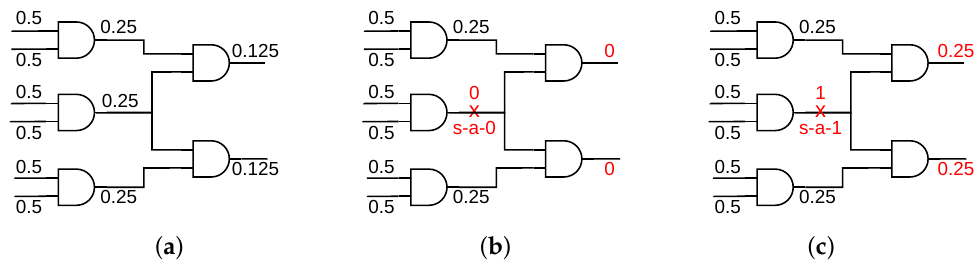
Figure 6. Signals probabilities when inserting stuck-at-faults: ( a ) initial probabilities, ( b ) modified probabilities if case of a s-a-0, ( c ) modified probabilities in case of a